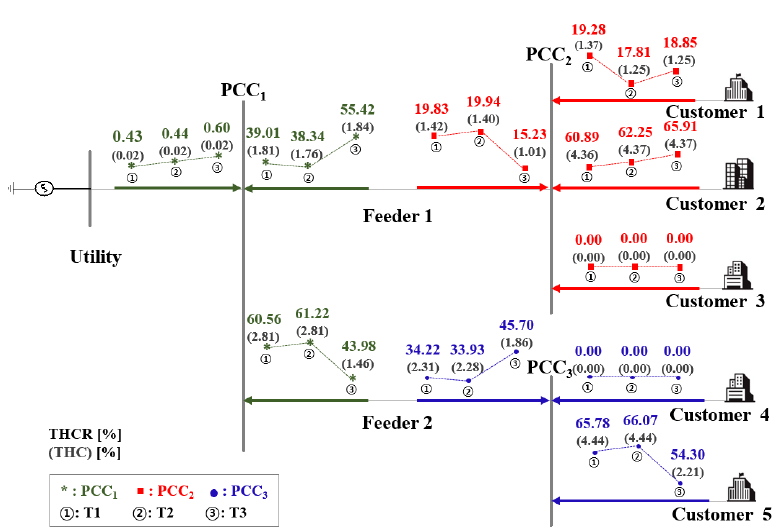
Figure 14. The harmonic contribution diagram displaying the estimated THC and THCR.